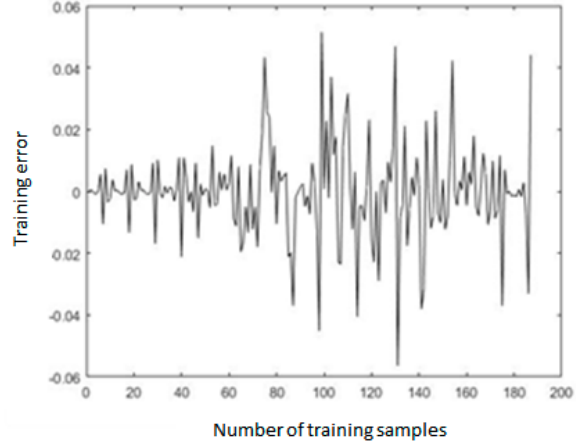
Figure 14. The distribution of sample error.